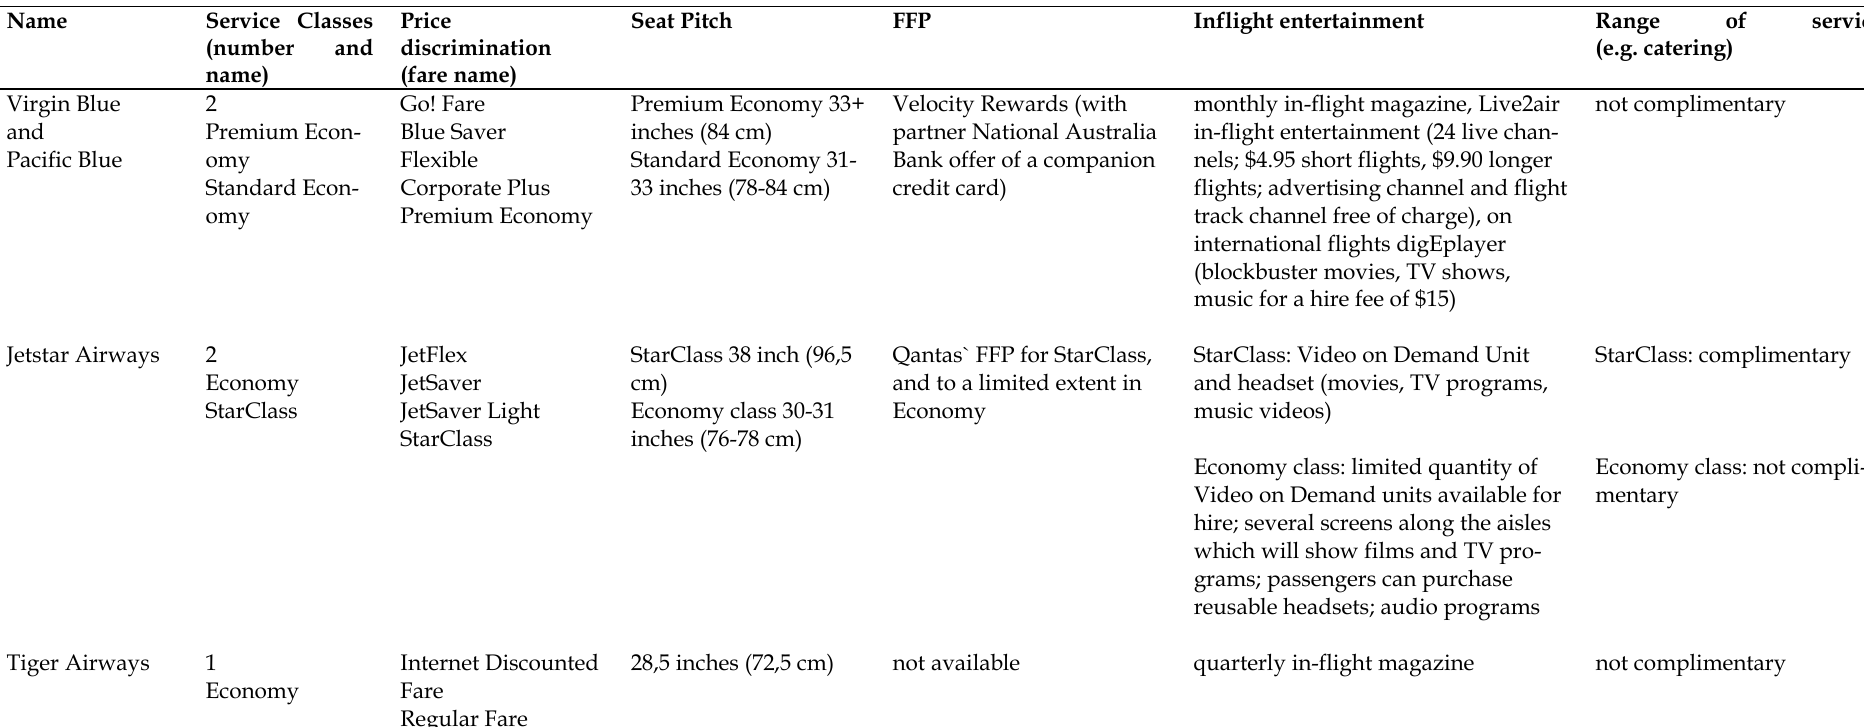
Table 6. Service Classes, Price Discrimination and Range of Services (February